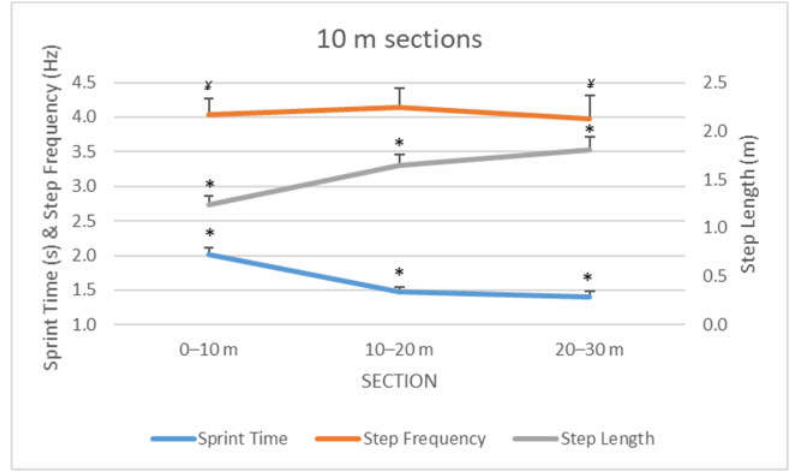
Figure 3. Evolution of step kinematics during the 10 m sections for the RSA test in elite female field hockey players. (*) Different from the rest of sections at p < 0.05; (¥) Different from the second section at p < 0.05.